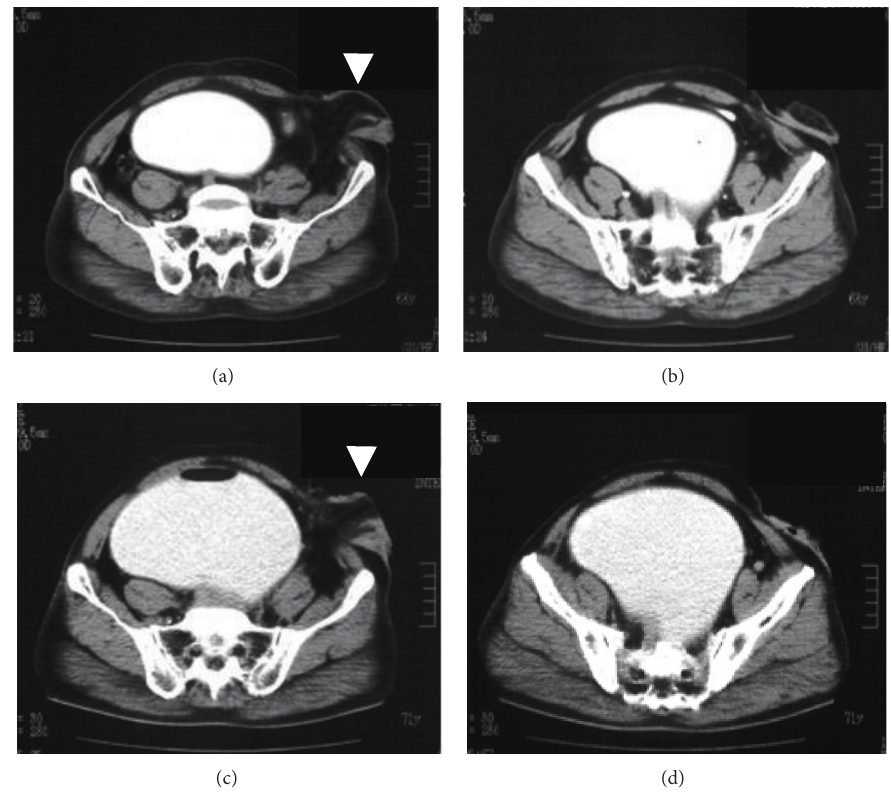
Figure 1: Computed tomography (CT) revealed a large cystic mass in the pelvic cavity at our surgical outpatient clinic ((c), (d)) and at another hospital two years previously ((a), (b)). A sigmoid divided colostomy was created in the left lower abdomen (arrow